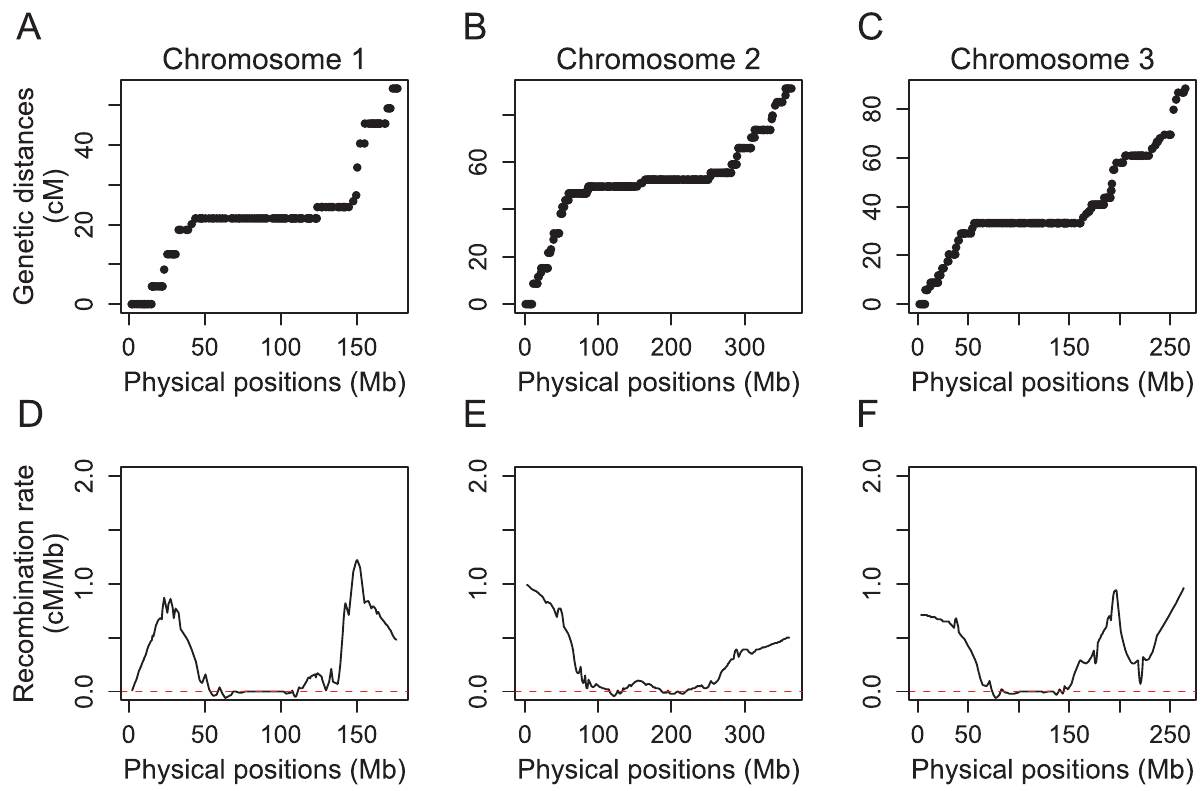
Figure 5. The relationship between genetic (cM) and physical map (Mb) positions and estimated local recombination rates across the three chromosomes of Ae.aegypti . The physical length was measured as the number of base pairs mapped to a particular genetic position for chromosomes A) 1, B) 2, and C) 3. Local recombination rates for chromosomes D) 1, E) 2, and F) 3 show depressed recombination in the centromeric regions of each chromosome.